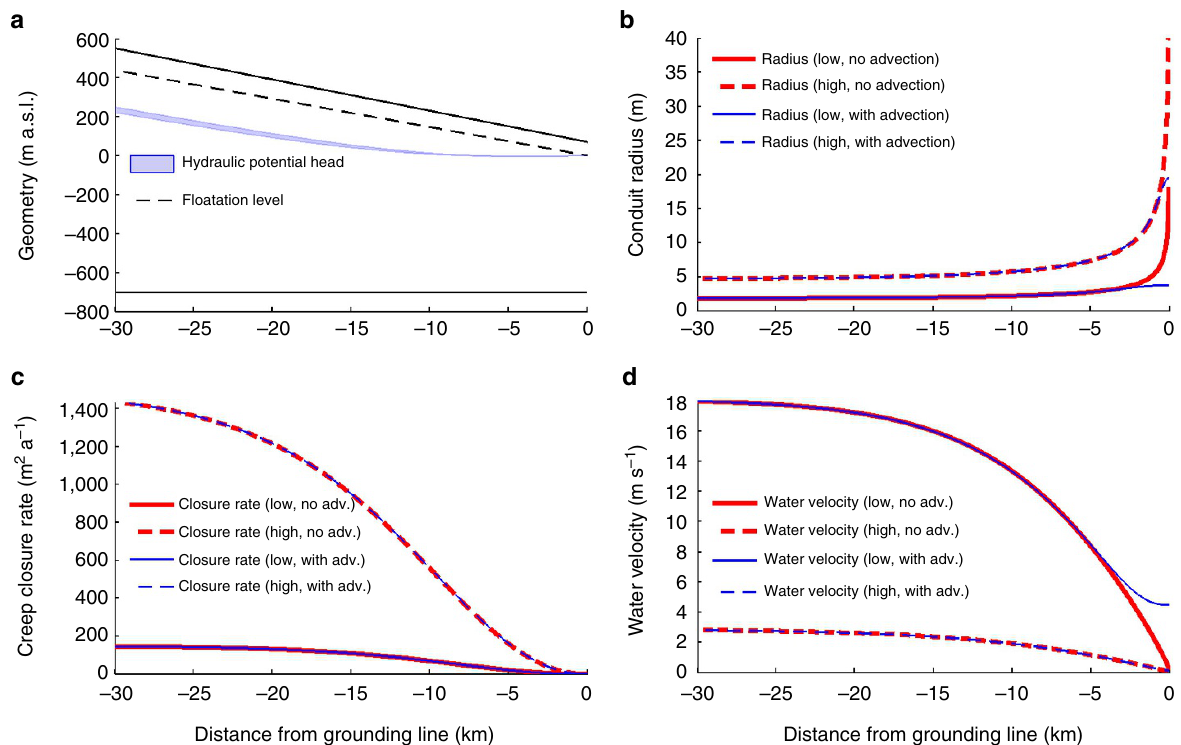
Figure 8 | Hydrological model for conduit-widening upstream of the grounding line. Steady-state solution for Ro¨thlisberger channels upstream of the grounding line. We present a lower (low: discharge Q ¼ 10m 3 s (cid:3) 1 , basal ice velocity u b ¼ 300ma (cid:3) 1 ) and an upper (high: Q ¼ 100m 3 s (cid:3) 1 , u b ¼ 1ma (cid:3) 1 ) scenario for the conduit cross-sections without (red) and with (blue) including ice advection. ( a ) Shows hydraulic potential (independent of ice advection) represented as metres of head in blue. Solid black line represents the ice surface elevation and dashed line represents the flotation level. ( b ) Shows radius of the conduit (without advection the radius tends to infinity at the grounding line). ( c ) Shows creep closure rate which equals the conduit-wall melting rate except close to the grounding line. ( d ) Shows the water velocity in the